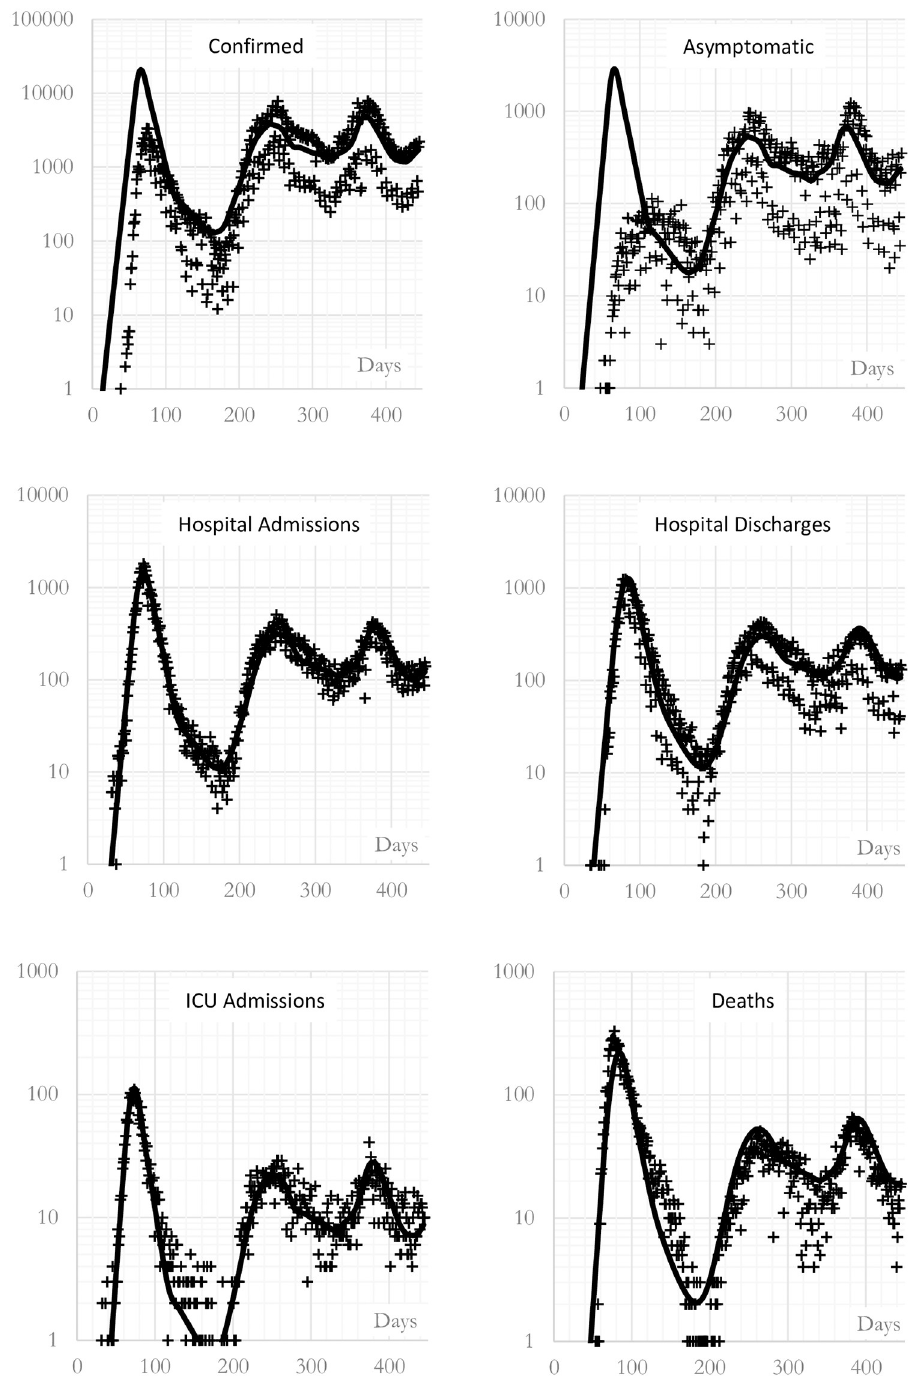
Fig 4. Calculated evolution of confirmed, asymptomatic, hospitalized, ICU and death cases during the studied period in the region of Madrid (CM). Lines are the curves calculated with the convolution mathematical model presented in this study. Points are actual data